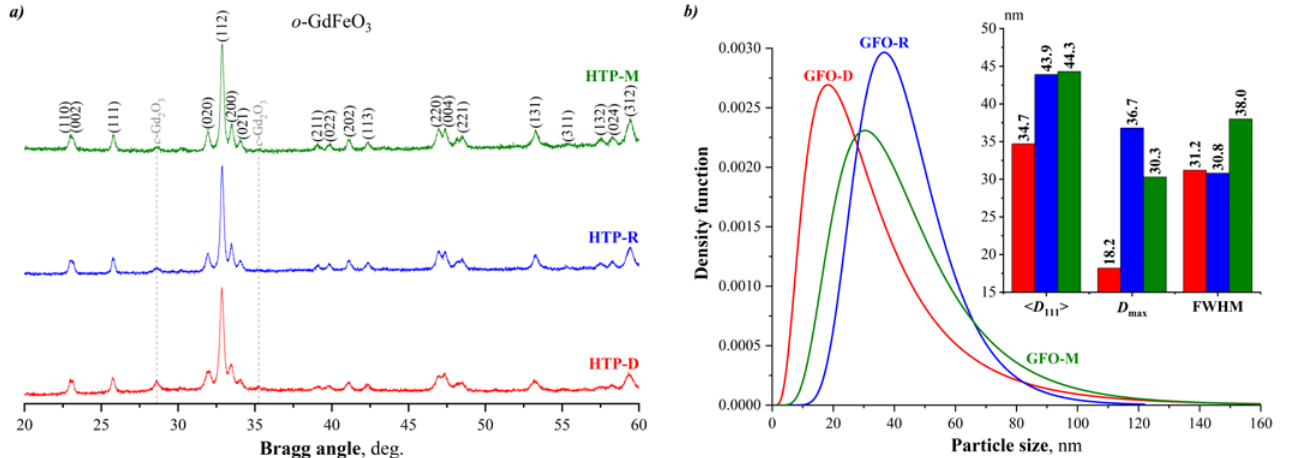
Figure 3. ( a ) X-ray diffraction patterns of the heat-treated products of co-precipitated hydroxides; ( b ) volume-weighted lognormal size distributions of the obtained GdFeO 3 crystallites and comparison of their parameters (average crystallite size, maximum and FWHM values of size distributions).